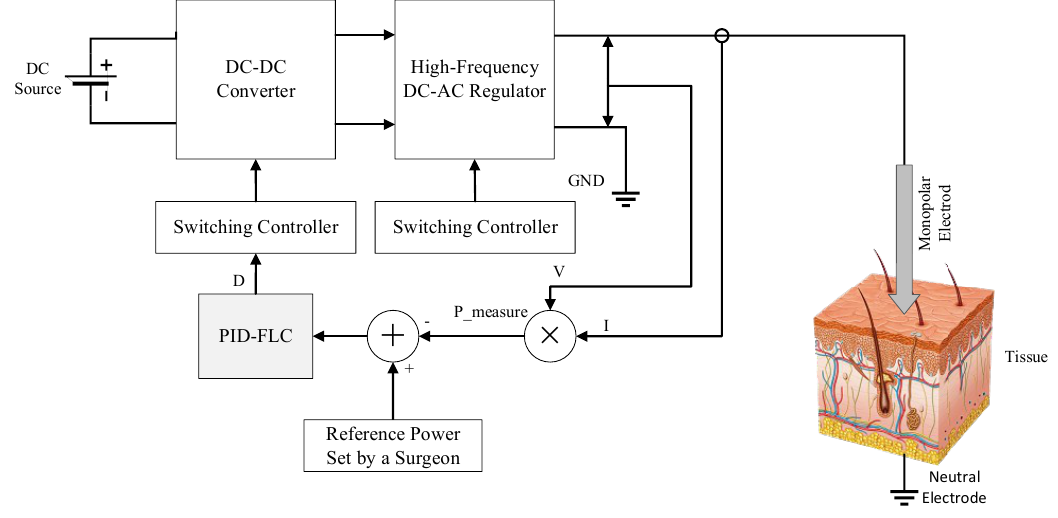
Fig.3: Block diagram of the proposed ESU.